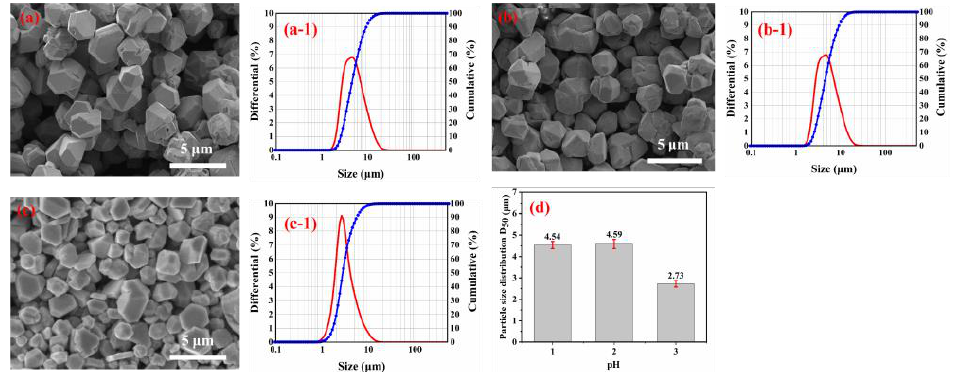
Figure 7. SEM images of silver particles prepared with different pH values: ( a ) pH = 1.0; ( b ) pH = 2.0; ( c ) pH = 3.0; ( d ) Variation of the average size of silver particles (D 50 ) with pH value. Size distribution of silver particles prepared with different pH values: (a-1) pH = 1.0; (b-1) pH = 2.0; (c-1) pH = 3.0.